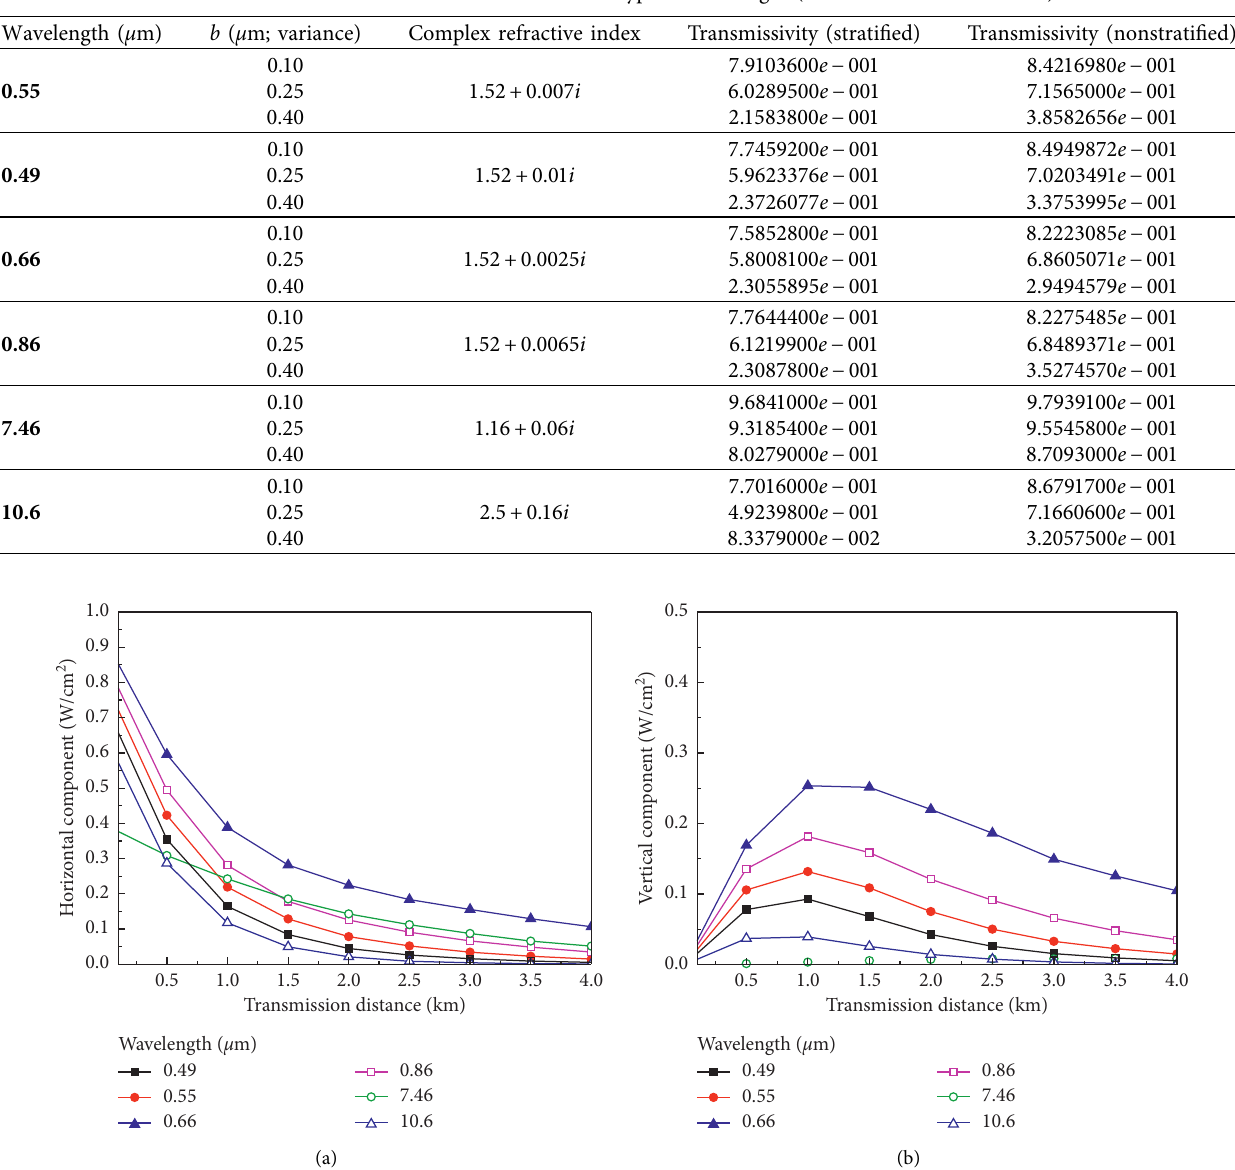
Figure 1: Horizontally polarized laser [1, 1, 0, 0] transmitted in the Martian dust: (a) horizontal component of horizontally polarized laser [1, 1, 0, 0] varying with the transmission distance and (b) vertical component of horizontally polarized laser [1, 1, 0, 0] varying with the transmission distance.